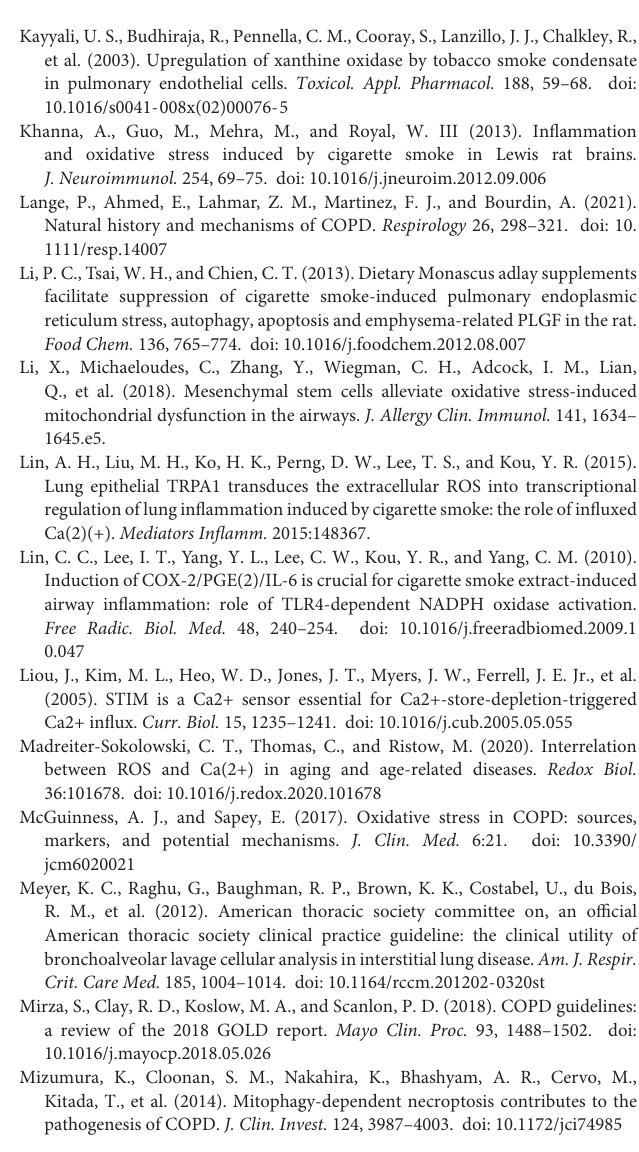
Supplementary Figure 2 | Cigarette smoke extract stimulation increased STIM1 expression in human macrophages isolated from BALF. Representative western blot image regarding STIM1 protein expression in macrophages treated with or without 5% CSE is shown (A) and quantified using ImageJ (B) . Data are expressed as mean ± SEM of at least three independent experiments. P -values were calculated using Student t -test. ∗∗∗ P < 0.001 represents significantly different relative to control. CSE concn, concentration of cigarette smoke extract; STIM1, stromal interaction molecule 1. Supplementary Figure 3 | Cigarette smoke extract stimulation lower than 10% conducted no distinct influence on cell viability in PMA-differentiated THP-1 macrophage. The effects of CSE on HBE cell activity was shown above. Data are expressed as mean ± SEM of at least three independent experiments. P